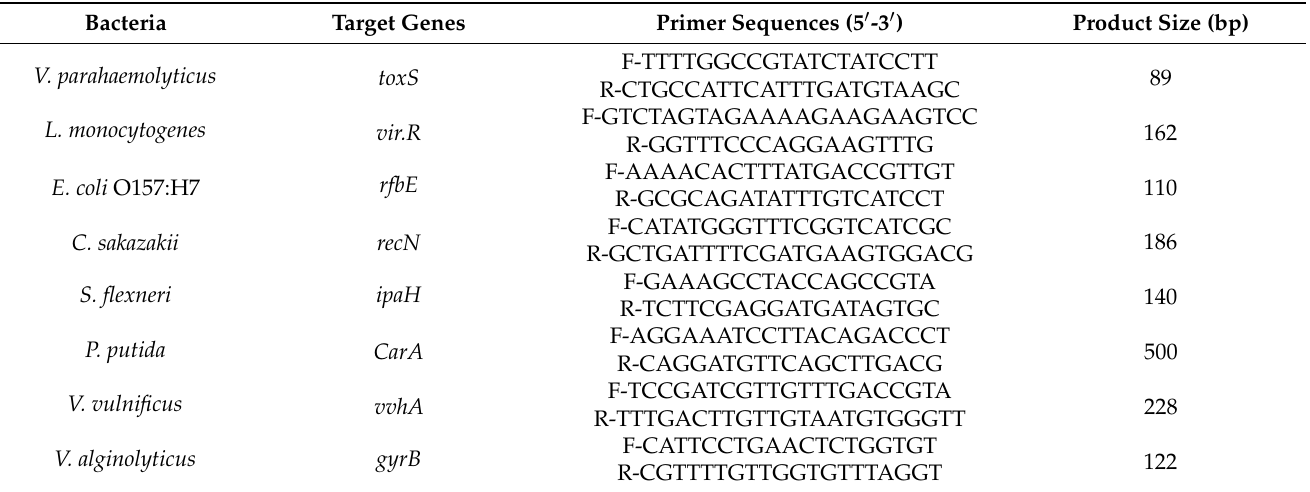
Table 2. Primers were used in this